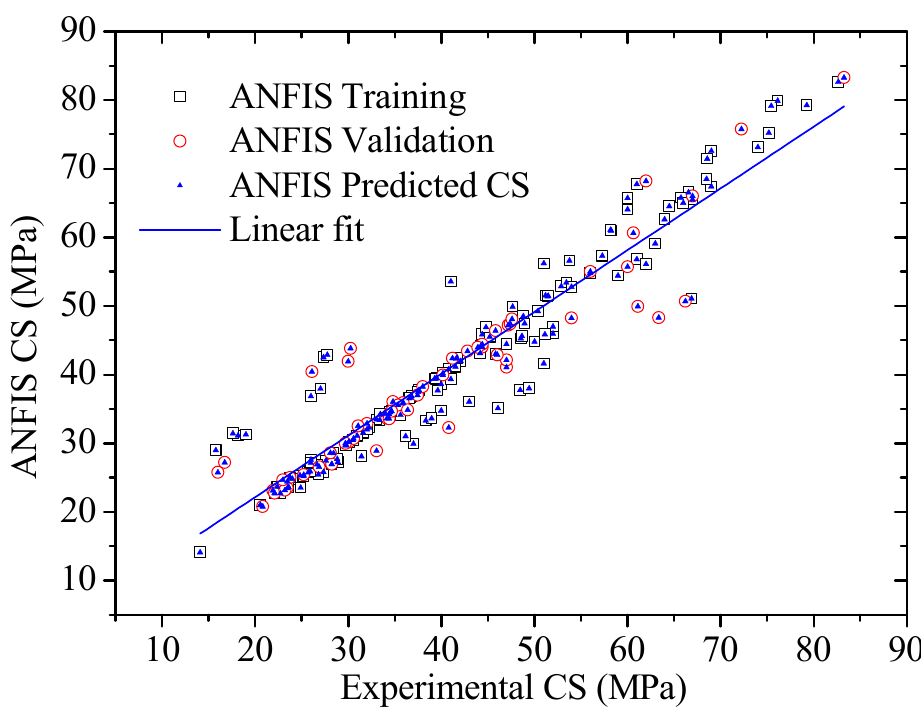
Figure 5. ANFIS: training, validation, and testing.